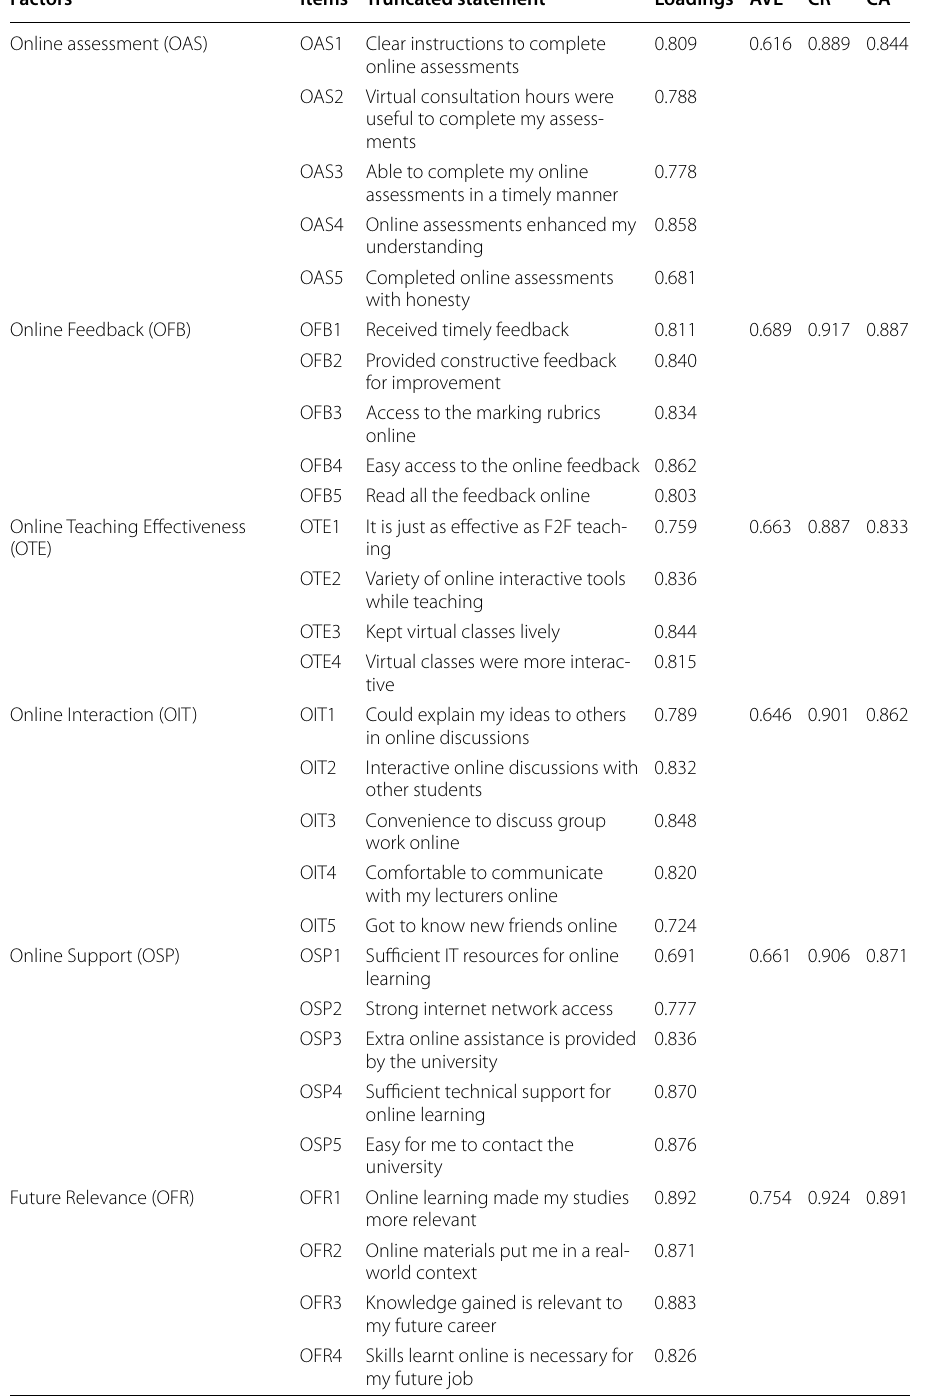
Table 3 Convergent validity